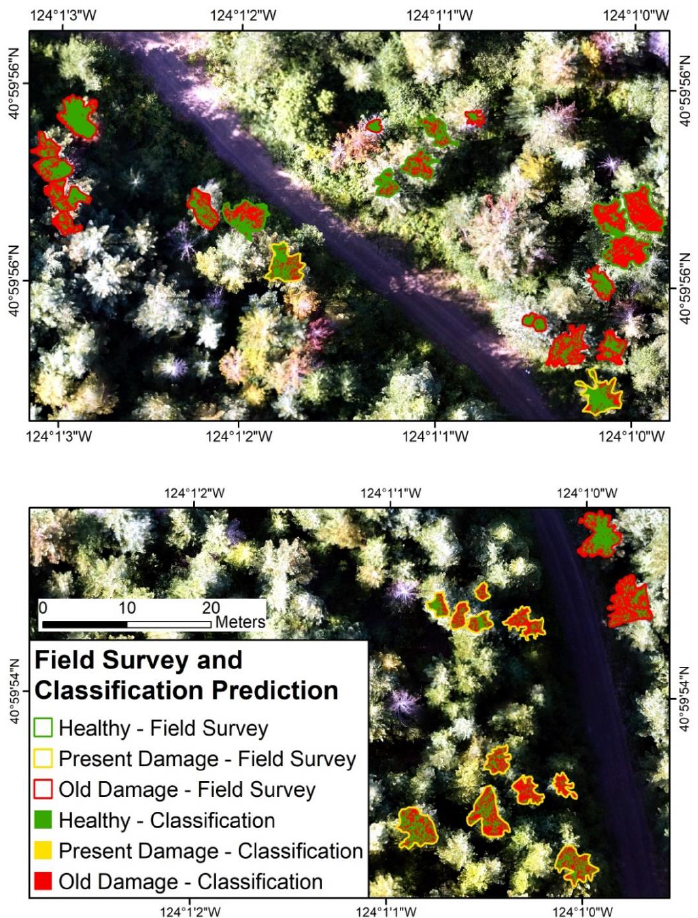
Figure 8. Comparing field observations (outline) to the tree health class prediction determined using the SVM classifier (pixel).